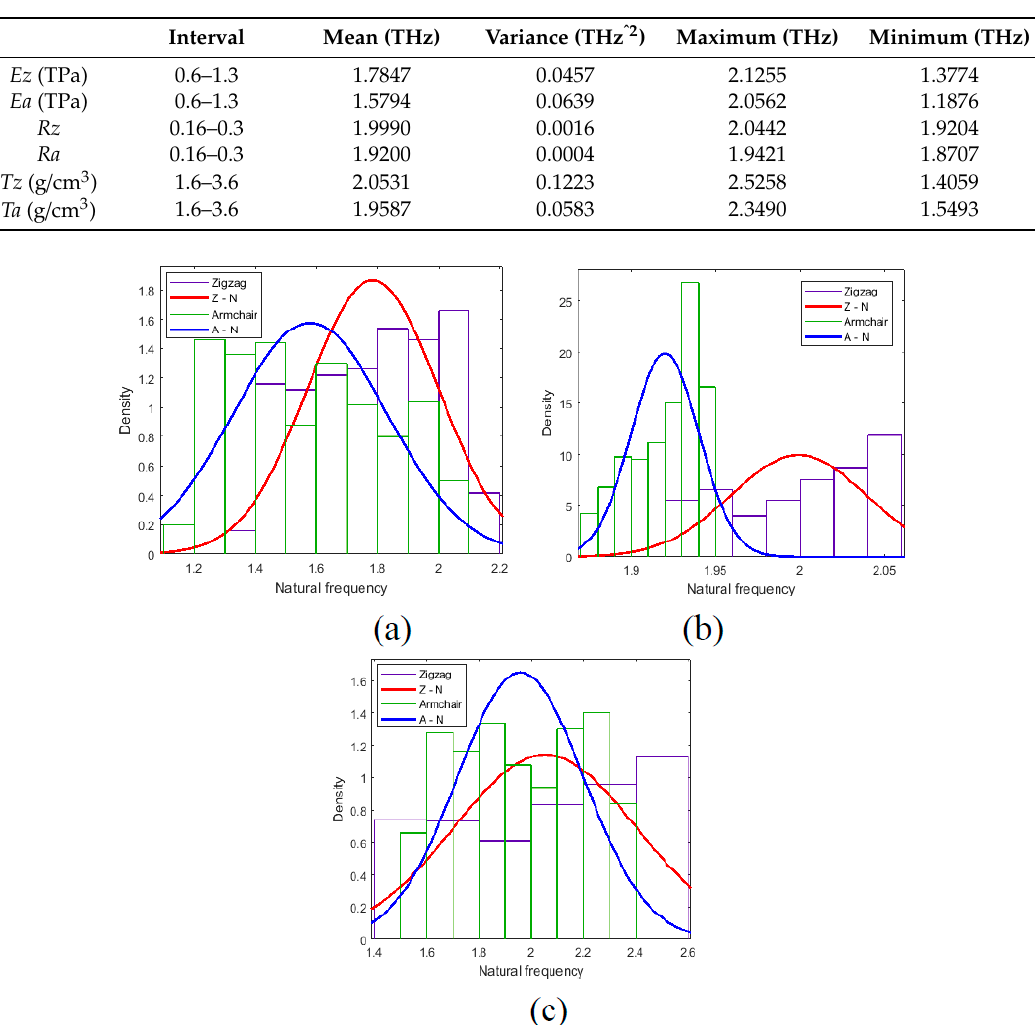
Table 4. Uncertainty analysis about parameters of material properties.